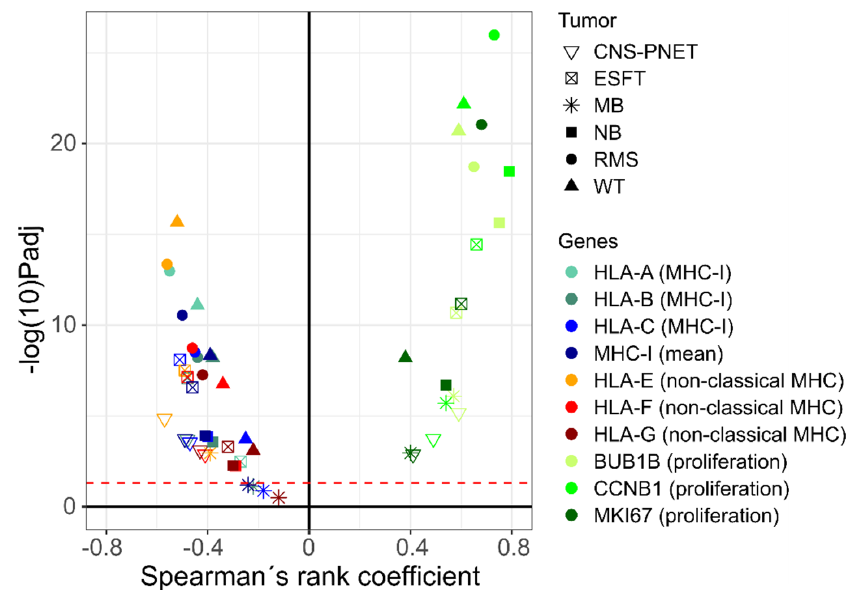
Figure 1. Mean MHC class I expression correlates negatively with stemness (mRNAsi) in CNS-PNET ( n = 59, r = − 0.49, p < 0.001), in ESFT ( n = 117, r = − 0.46, p < 0.001), in MB ( n = 76, r = − 0.24, p =